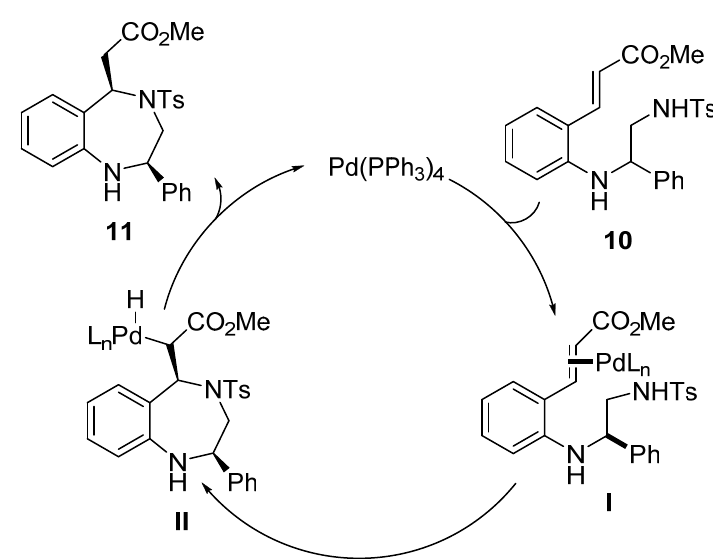
Scheme 6. Proposed mechanism for the synthesis of tetrahydrobenzodiazepine 11 .